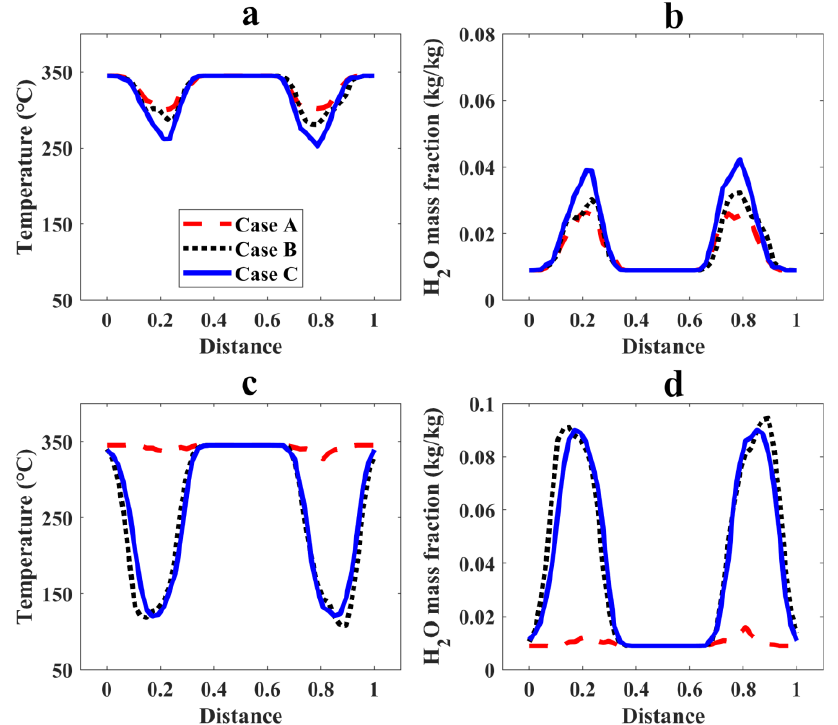
Figure 7. Radial temperature ( a , c ) and moisture ( b , d ) distribution at z/Z = 0.75 for centerlines of X-Z ( a , b ) and Y-Z ( c , d )